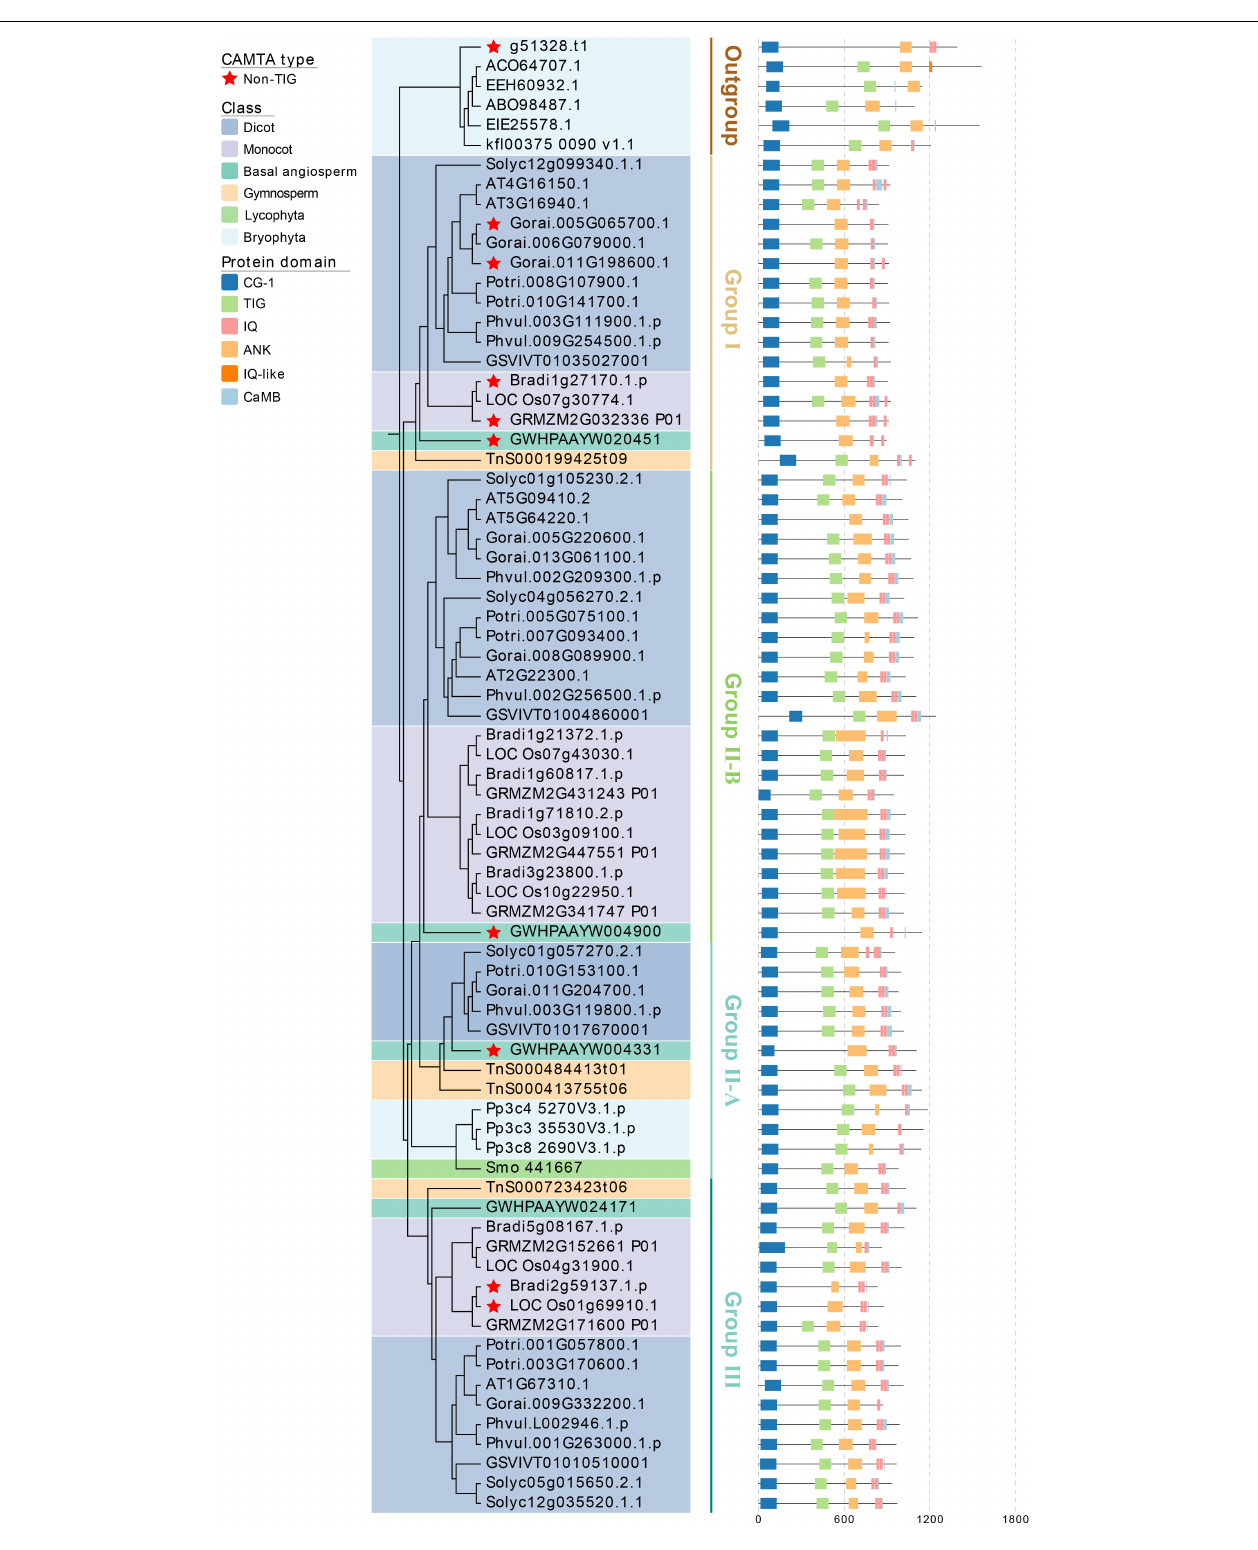
FIGURE 4 | Phylogenetic tree and functional domains of CAMTAs in representative species. CG-1, CG-1 DNA-binding domain; TIG, transcription-associated immune globulin-like domain; ANK, ankyrin repeat domain; IQ, Ca 2 + -independent CaM-binding IQ motif; CaMB, Ca 2 + -dependent CaM binding domain.